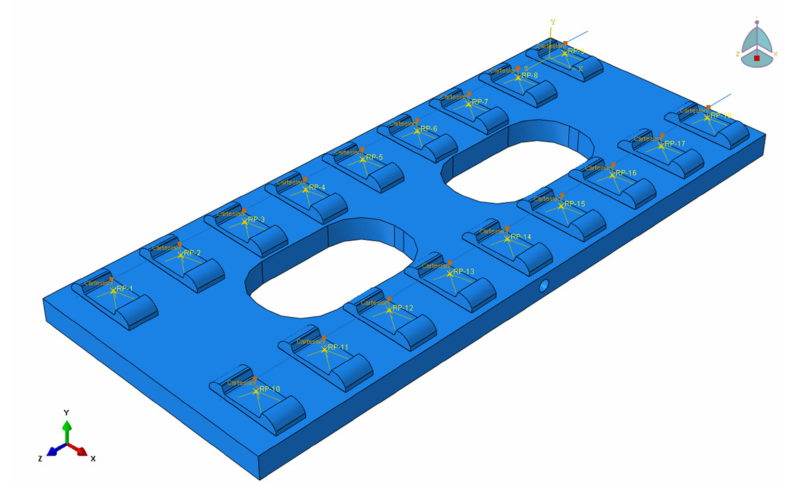
Figure 4. Three-dimensional view of the optimized design of the track slab.